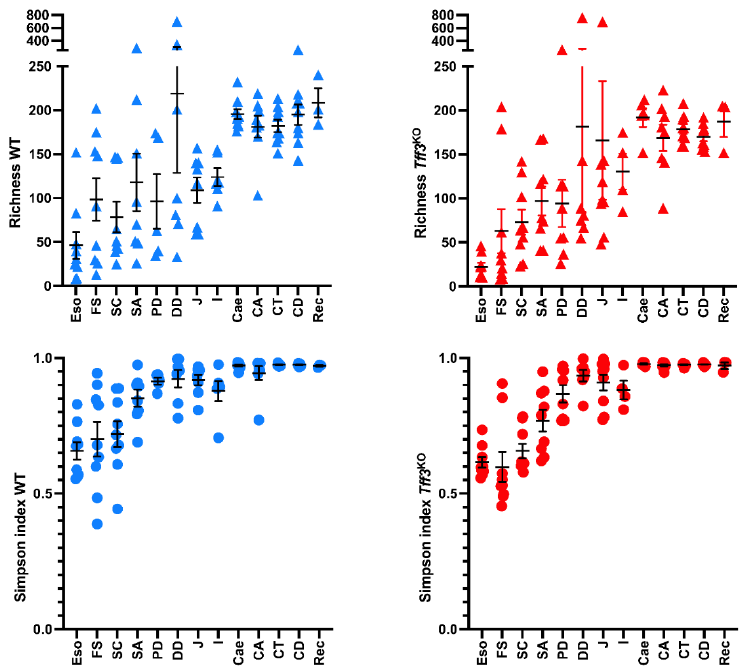
Figure 1. Richness ( top ) and Simpson index ( down ) in wild-type (left panel, in blue) and Tff3 KO (right panel, in red) mice through the gastrointestinal tract; esophagus (Eso), forestomach (FS), stomach cor- pus (SC), stomach antrum (SA), proximal duodenum (PD), distal duodenum (DD), jejunum (J), ileum (I), caecum (Cae), ascending colon (CA), transverse colon (CT), descending colon (CD), and rectum